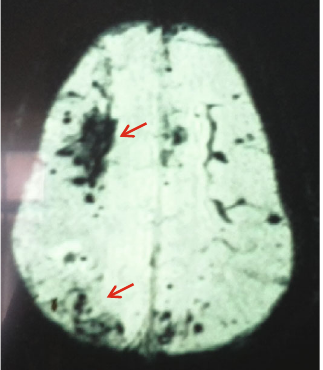
Figure 2: MRI/SWI image of the brain. There is a signi fi cant blooming with multiple peripheral and central bleeding foci in the cerebral hemispheres (arrow).